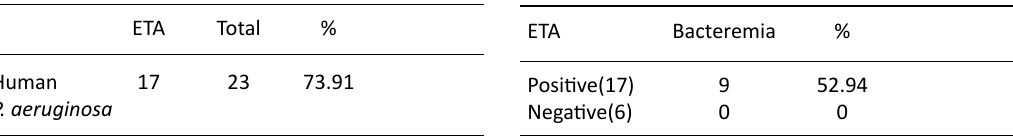
Table 5. Mean levels of interferon gamma and IL-18 among burned patients in relation to pseudomonas aeruginosa infection